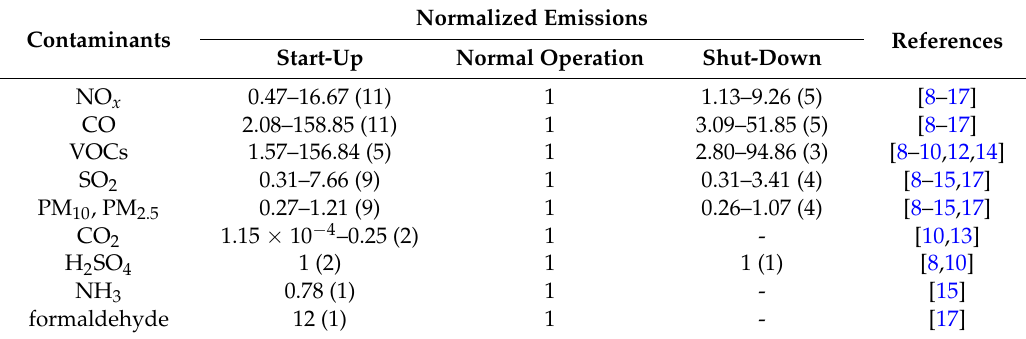
Table 1. Normalized emissions from power and/or heat generation facilities under start-up, normal, and shut-down operating conditions (number of facilities investigated shown in